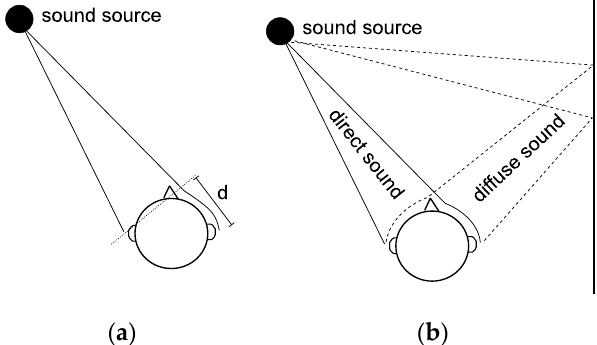
Figure 5. Illustration of different binaural sound propagation to the ears. ( a ) Propagation path length difference; ( b ) direct and diffuse sound due to wall reflection.